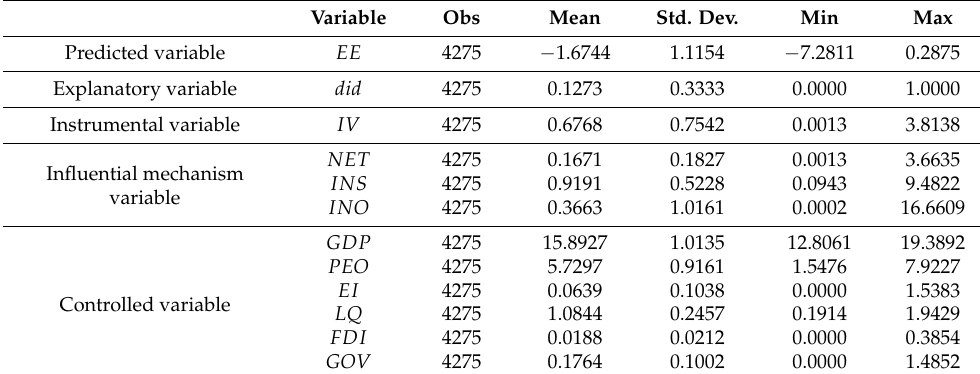
Table 2. Descriptive statistics of